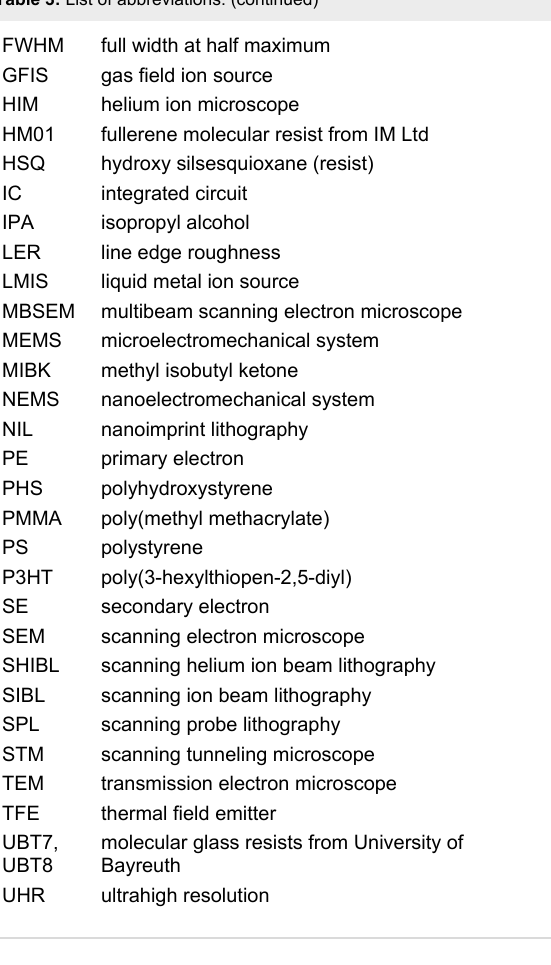
Table 3: List of abbreviations.